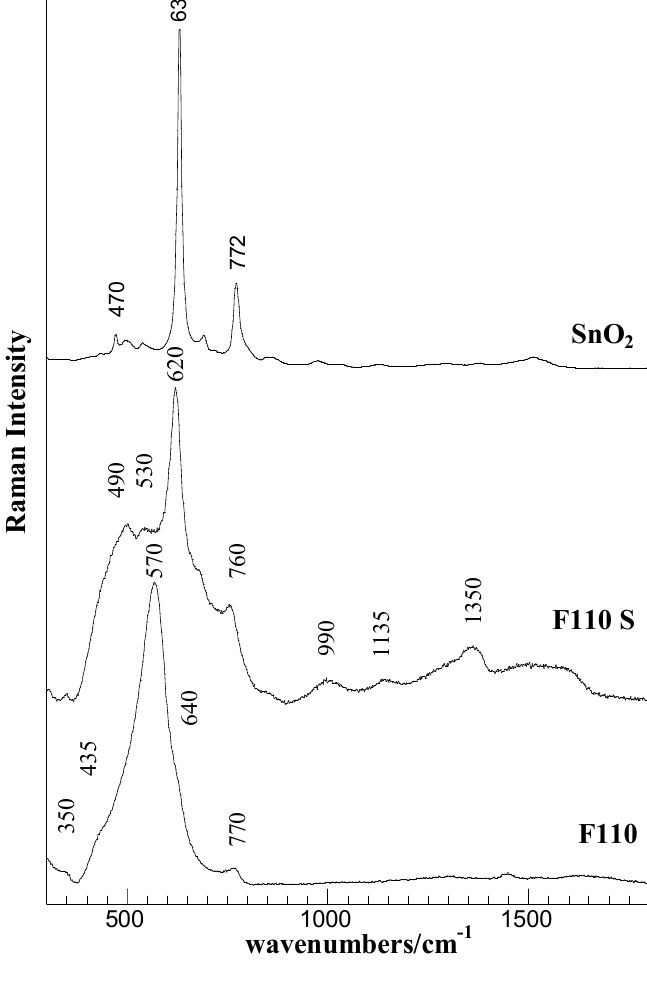
Figure 5. Raman spectra of the F110 and F110S samples and of bulk SnO